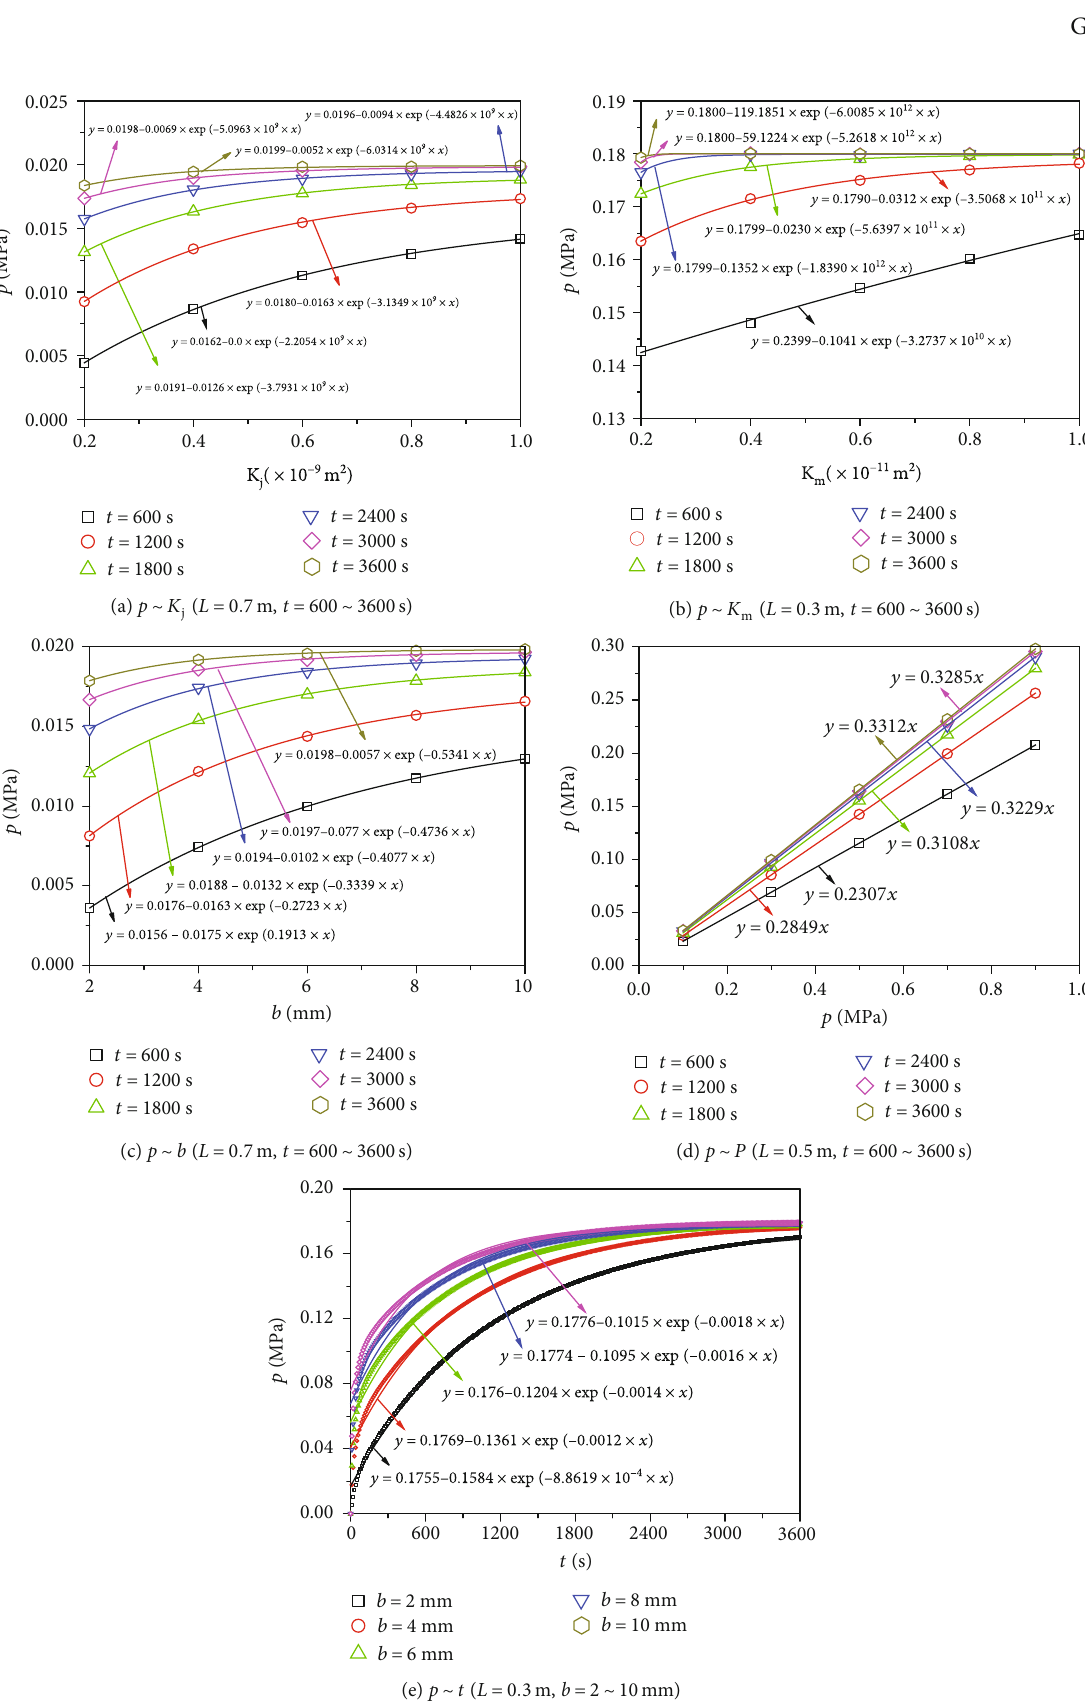
Figure 15: Regression analysis of p as a function of K